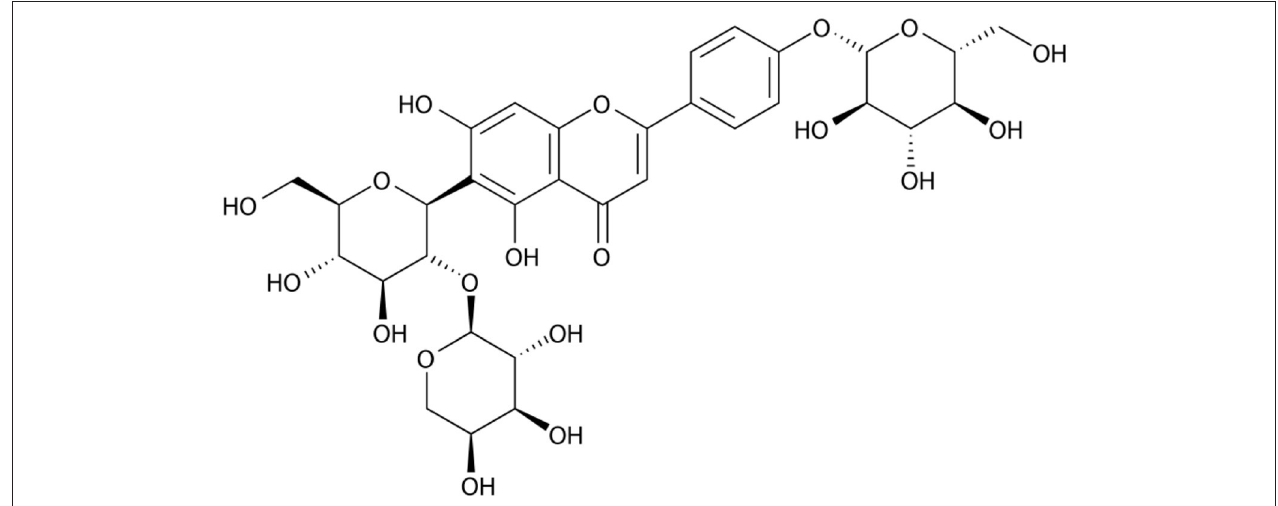
FIGURE 1 | Structure of